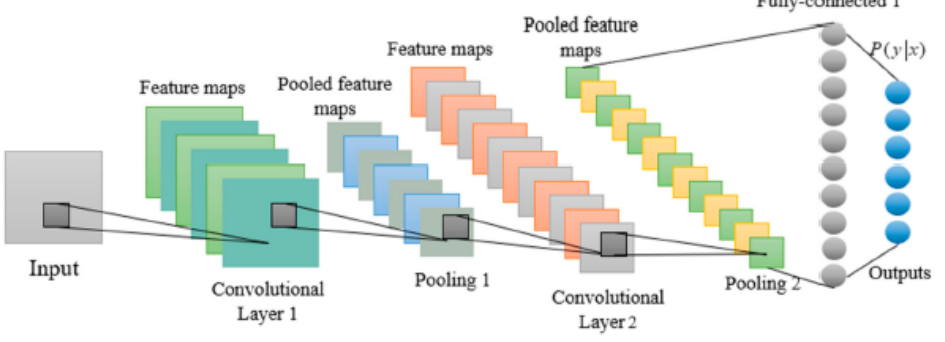
Figure 1. Standard Convolutional Neural Network Architecture [65].